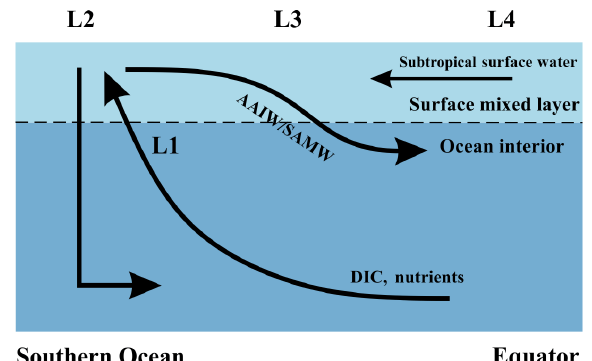
Figure 4. A schematic illustrating locations of interest and assumed major flow paths in the Southern Ocean. Black arrows represent the flow directions of water masses. The lower curved arrow denotes upwelling of deep water along isopycnal surfaces, and the upper curved arrow denotes subduction to form Subantarctic Mode Water (SAMW) and Antarctic Intermediate Water (AAIW). L1: upwelling water below the mixed layer, prior to any influence of surface pro- cesses; L2: sea surface within the core of the Southern Ocean up- welling south of 50 ◦ S (Morrison et al., 2015); L3: sea surface from 30 to 50 ◦ S; L4: sea surface north of 30 ◦ S, which experiences no direct effects from upwelling in the Southern